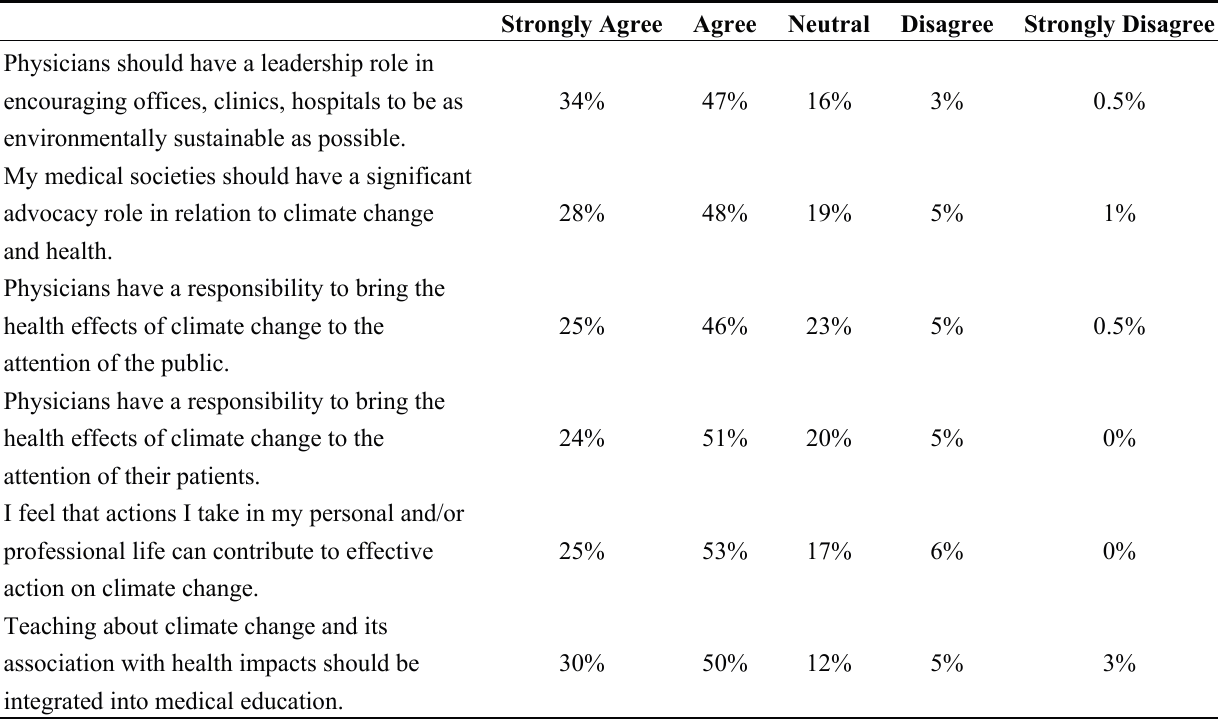
Table 2. African American physicians’ response preferences and self-efficacy for dealing with climate change as a health issue. Strongly Agree Agree Neutral Disagree Strongly Disagree 34% 47% 16% 3%